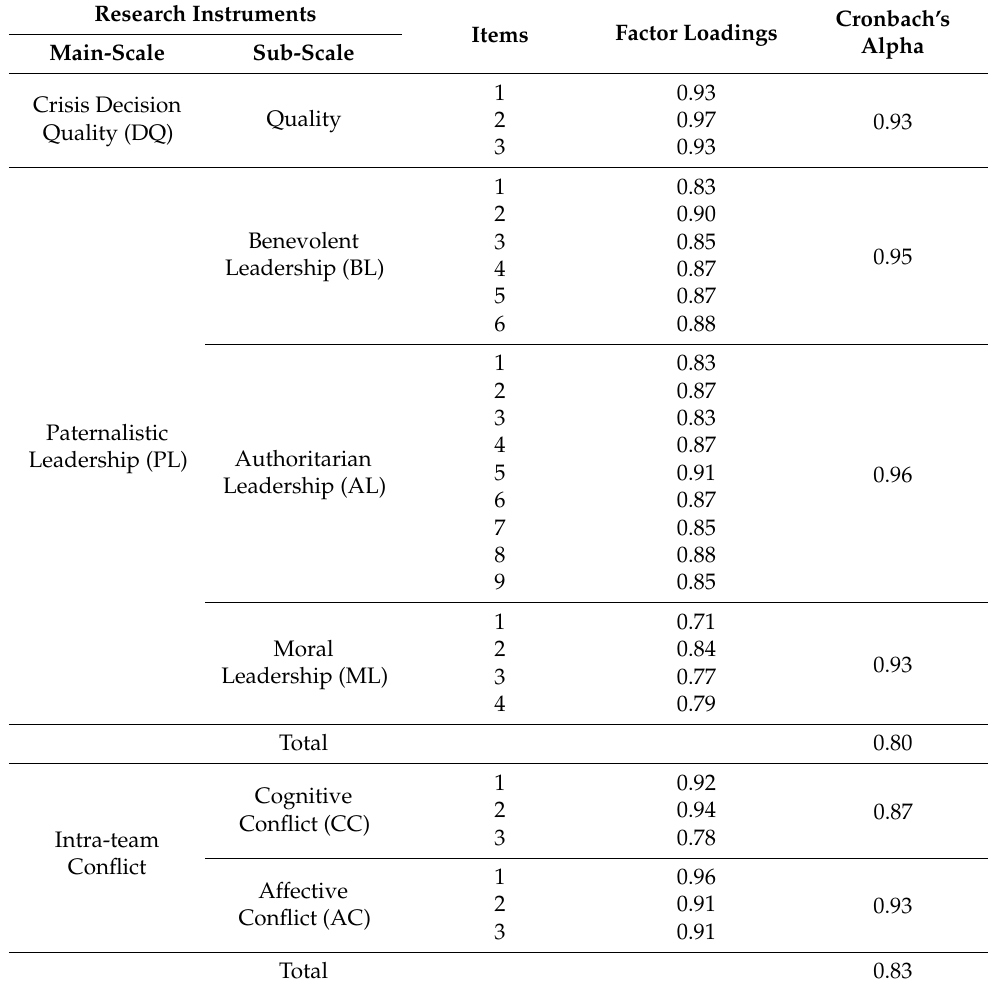
Table 1. Validity and Reliability Analysis of Research Instrument.